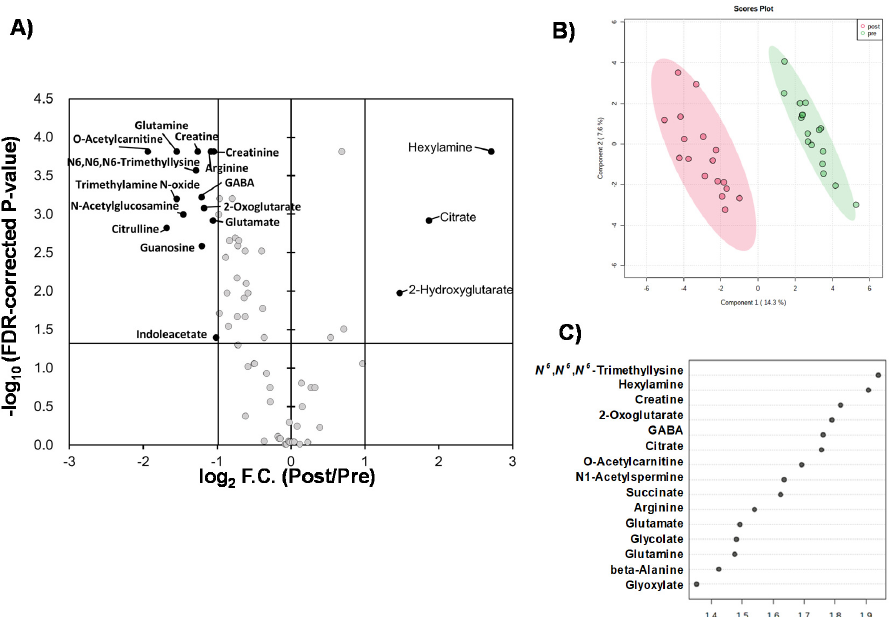
Figure 1. Comparisons of quantified metabolites. ( A ) Volcano plot. The X -axis indicates log 2 -fold change (FC) of metabolite concentrations in PRE sample divided by those of POST sample. Vertical bars indicate FC = 0.5 and 2.0. The Y -axis indicates − log 10 (FDR-corrected p -value). The horizontal bar indicates FDR-corrected p = 0.05. ( B ) Score plots of PLS-DA. X and Y axes indicate the 1st and 2nd components. The R 2 and Q 2 values are 0.968 and 0.856 (average of 5 times of 7-fold cross-validation), respectively, with two components. Quantile normalization of each sample was conducted, and subsequently, metabolite concentration was normalized by autoscaling to eliminate sample-dependent bias. One plot indicates one sample of PRE (red) and POST (green). The light circles indicate 95% confidential intervals. ( C ) Variable importance in projection (VIP) showing top 15 metabolites. One plot indicates a metabolite. The right box indicates the higher or lower average concentrations of 0 W and 4 W.